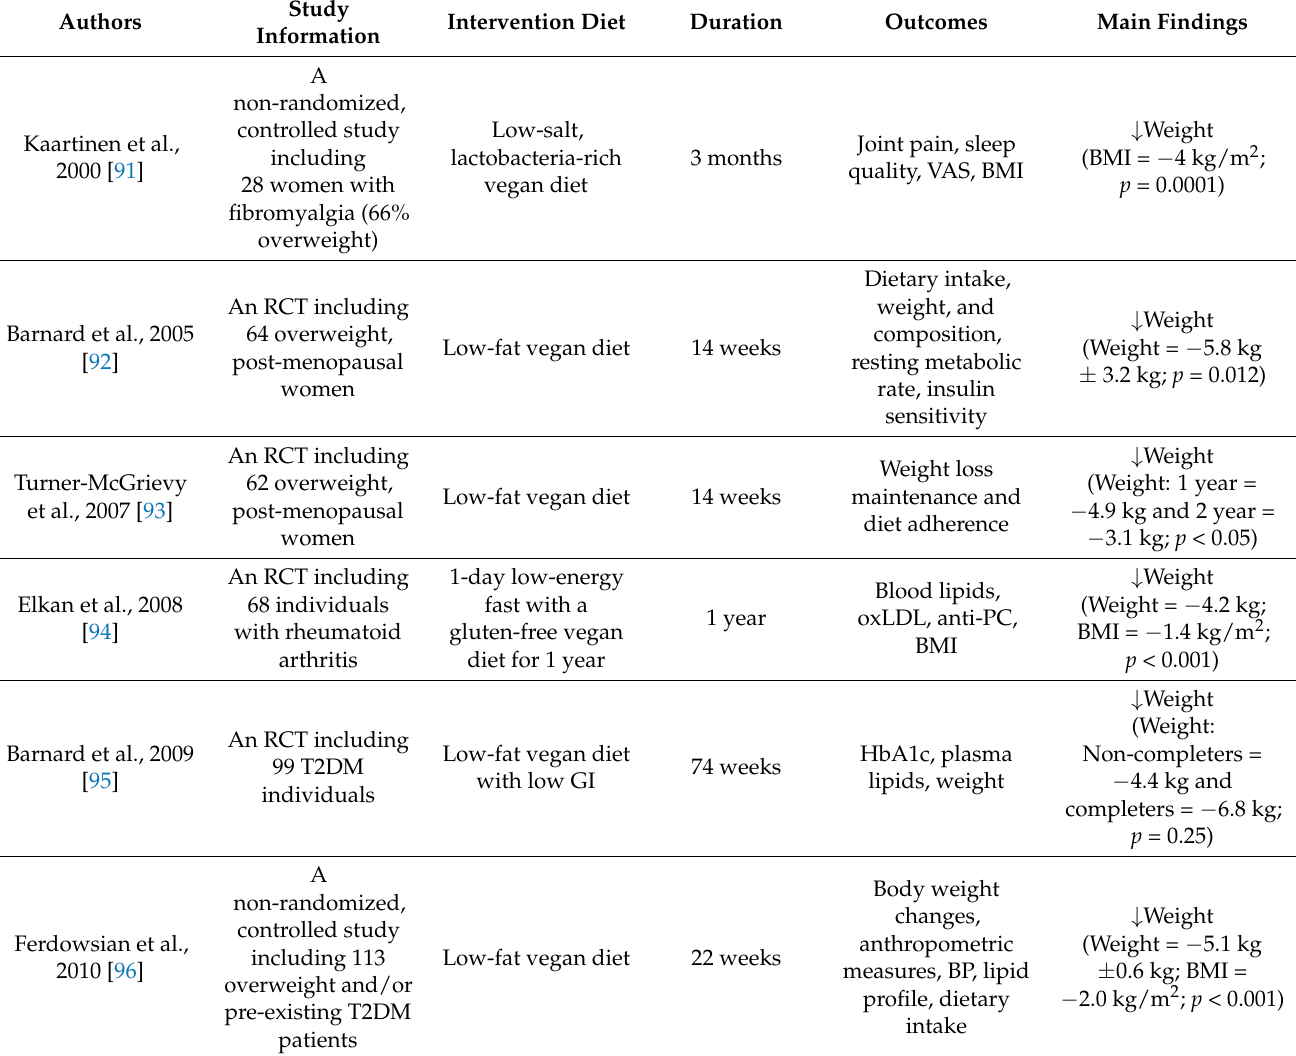
Table 2. Summary of relevant outcomes and main findings in the included